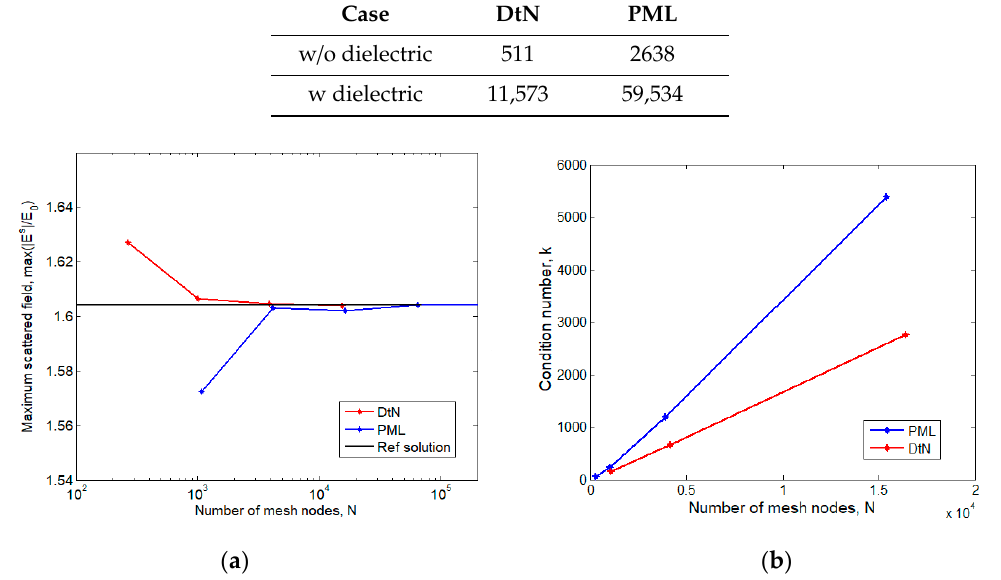
Figure 5. Case study 2 (cable bundle in air). ( a ) Maximum value of the scattered field, normalized to amplitude of the incident field, versus the number of mesh nodes: The DtN and PML solutions are compared to the reference one. ( b ) Condition number of the stiffness matrices associated with the two numerical solutions, versus the number of mesh nodes.